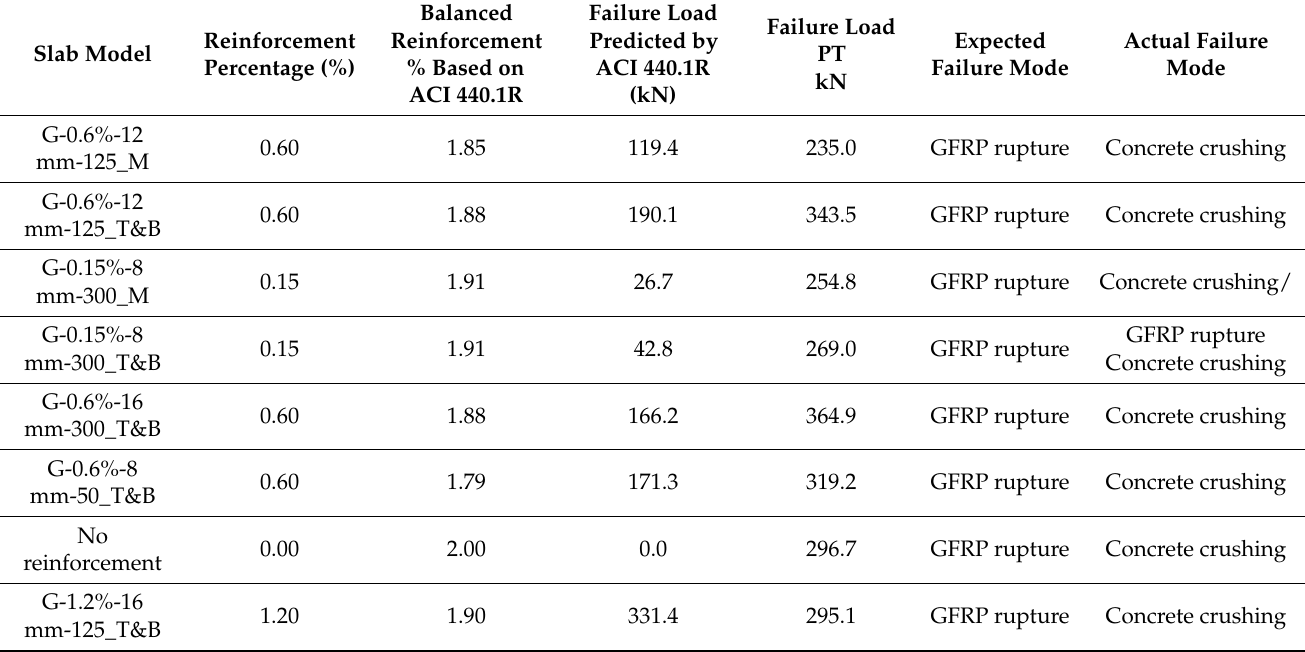
Table 3. Failure load and mode of test